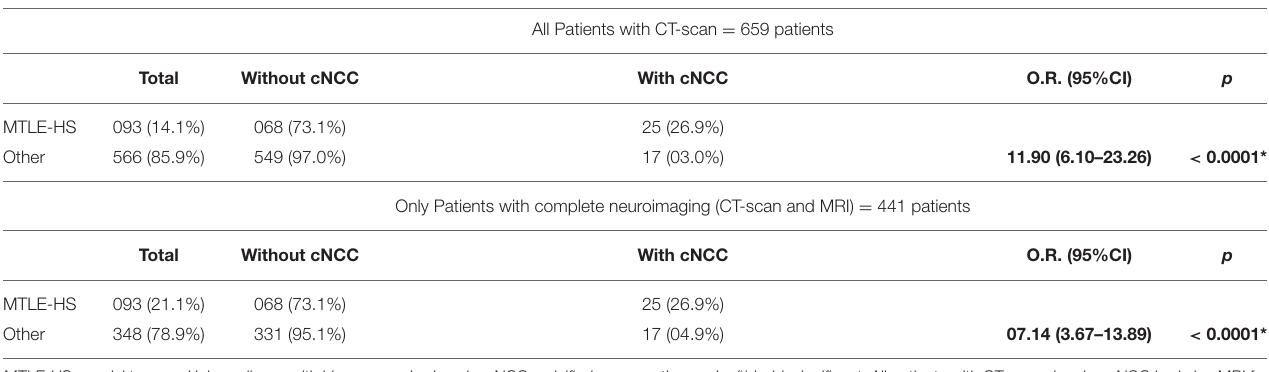
All Patients with CT-scan = 659